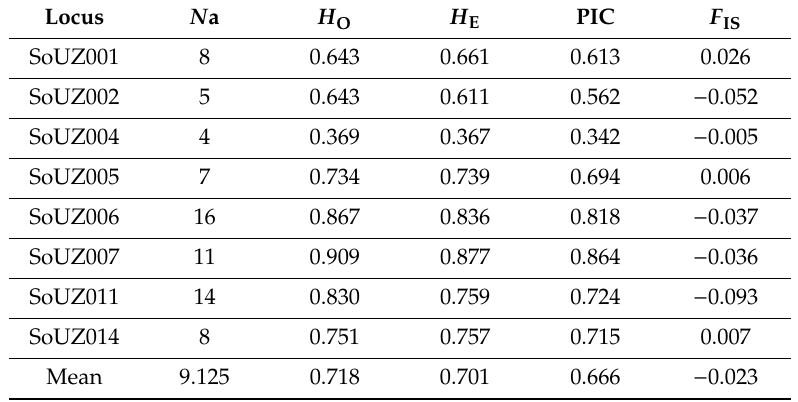
Figure 5. Distribution of genets in accordance with their size: 1) main plot—genet size in terms of the number of sampled ramets sharing the same multilocus genotypes (MLG), 2) small plot—genet size ( A GEN ) in terms of the surface areas (m 2 ) occupied by the individual genets (represented by convex hull polygons for MLGs with at least three collected ramets and by buffer polygons for MLGs with one or two collected ramets). Genotypic richness (based on the 687 collected ramets sorted into 241 MLGs) had a value of 0.35. The slope of the Pareto distribution had a moderate value of 0.69, while the value obtained for the aggregation index ( A c ) was 0.73. A maximum clonal subrange of 10.90 metres was detected in the largest group of patches and refers to the largest genet recognized by 55 sampled ramets. The Shannon–Wiener equitability index had a value of 0.91.